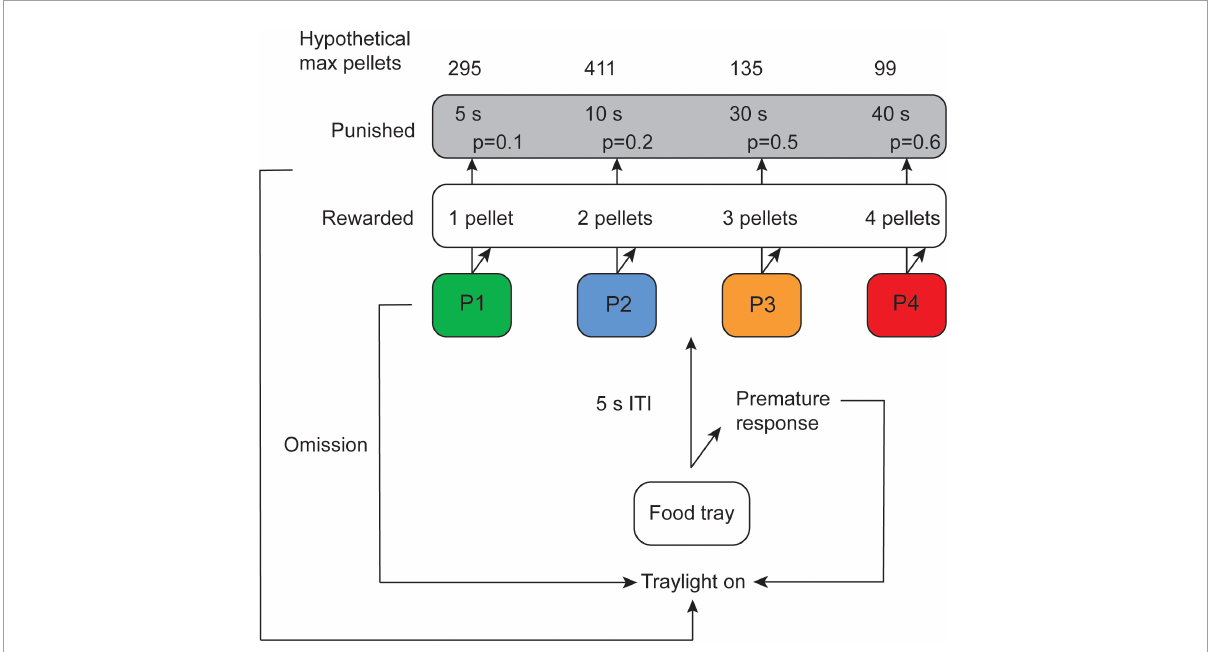
FIGURE1 Schematic of the rat gambling task (rGT) displaying contingencies with regard to number of rewarded pellets as well as probability and duration of punishing timeouts for the different options (modified from Tjernström et al., 2022). Omissions and premature responses in the rGT have been described elsewhere (Tjernström et al., 2022; Tjernström and Roman, 2022; manuscript resubmitted for review) but were not used in the present study. ITI, inter-trial-interval.